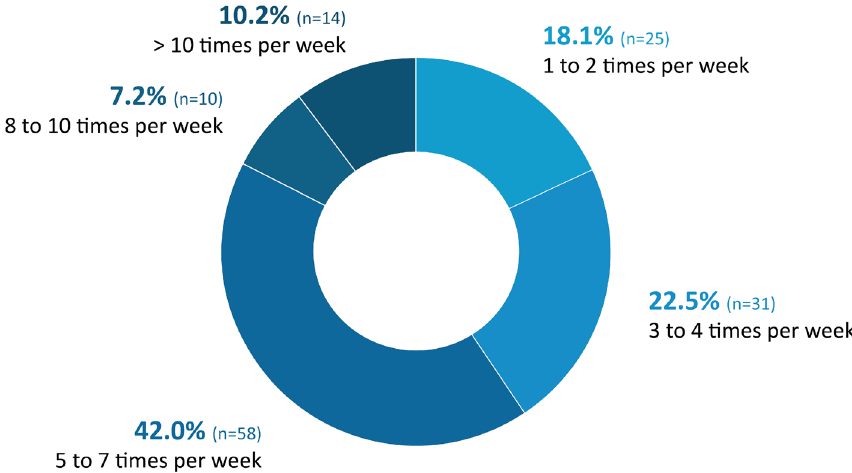
Figure 1. Use of motor-assisted movement exerciser (MME). MME use was broken down into the following categories: 1 to 2 times per week, 3 to 4 times per week, 5 to 7 times per week, 8 to 10 times per week, and more than 10 times per week. n = 138; n number of participants.